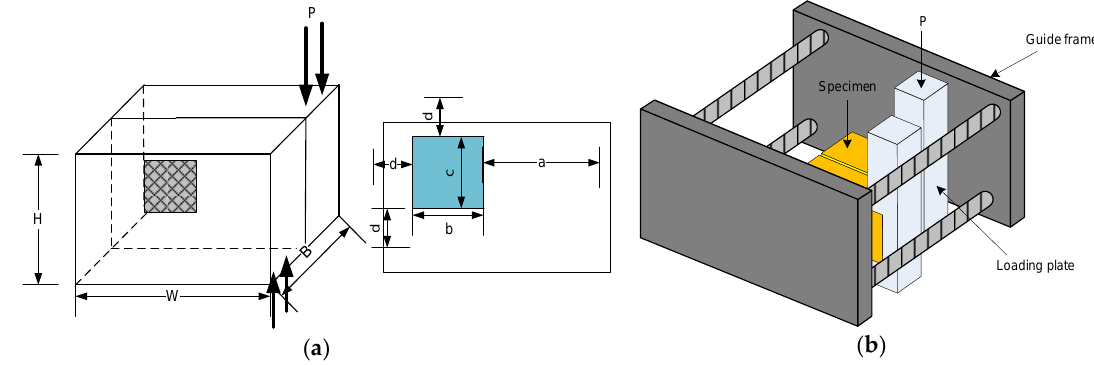
Figure 6. Torsion test of rectangular section specimens: ( a ) specimen geometry; ( b ) test set-up. T he values of α for the ratio b/c is shown in Figure 7.